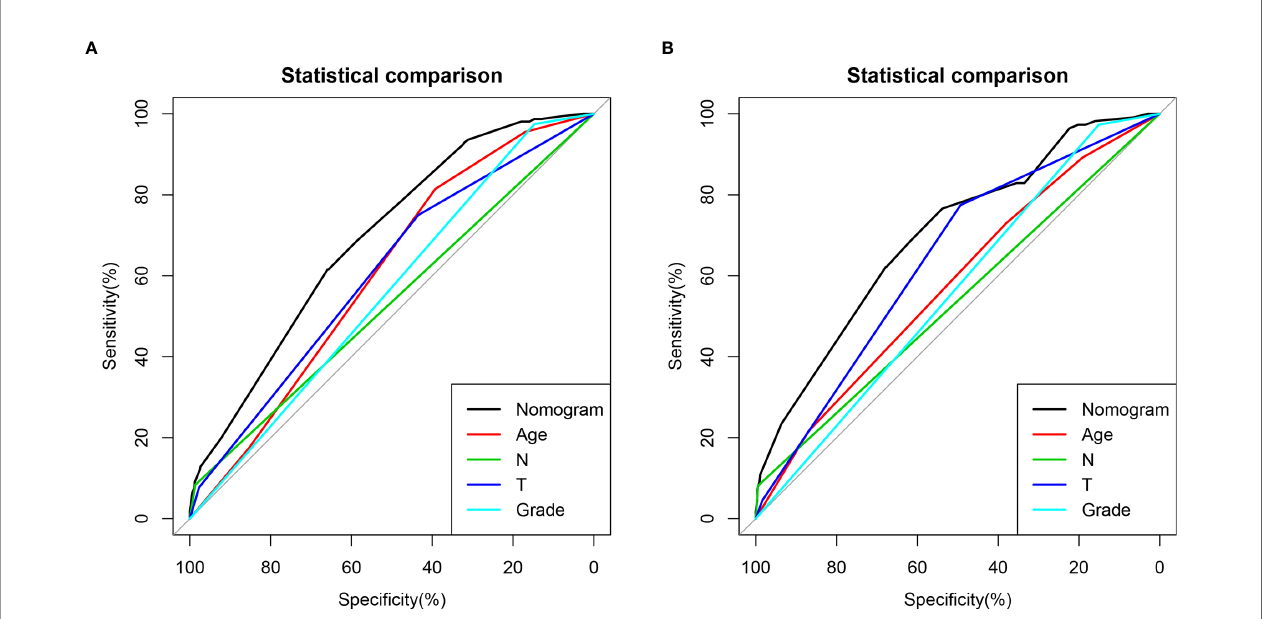
FIGURE 2 | Comparison of area under the receiver operating characteristic curves between nomogram and all independent factors, including Grade, T stage, N stage, and Age in the training set (A) and Validation set (B)